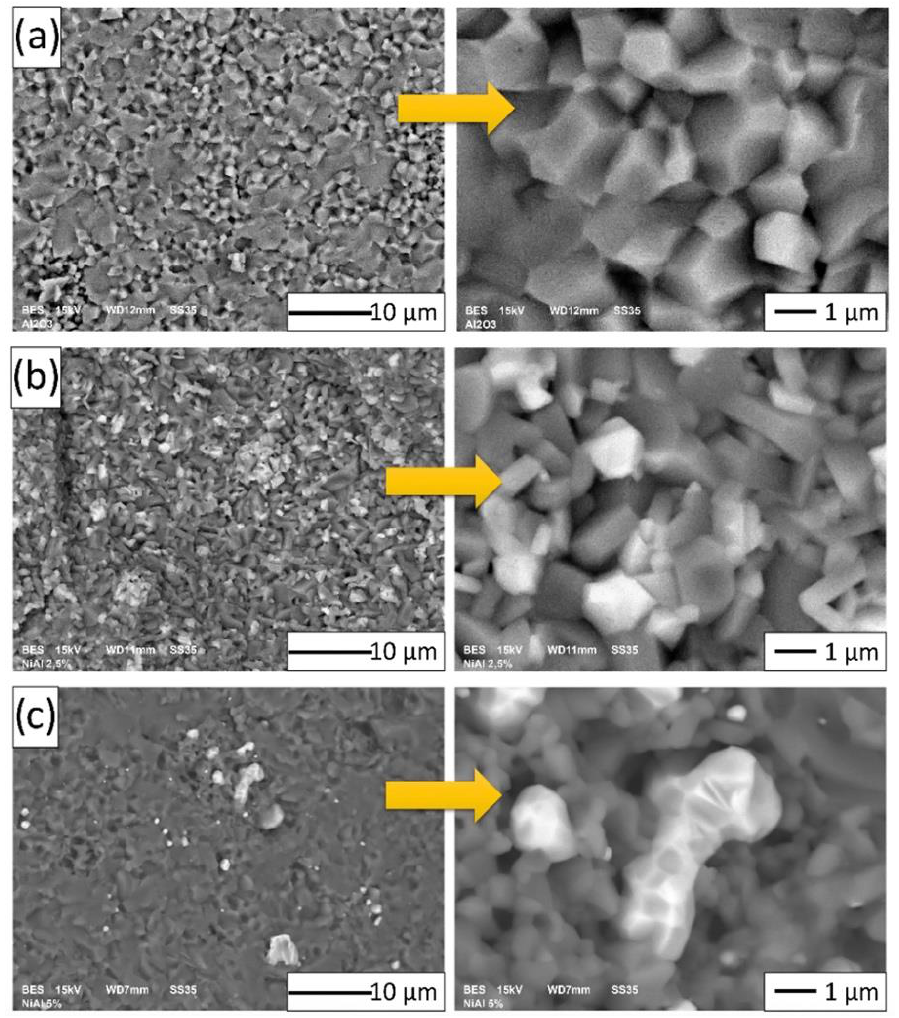
Figure 13. Scanning electron micrograph of the fractures in the fabricated samples: ( a ) Series I—100 vol.% of Al 2 O 3 ; ( b ) Series II—Al 2 O 3 + 2.5 vol.% of NiAl + 30 wt.% A 2 O 3 ; ( c ) Series III—Al 2 O 3 + 5 vol.% of NiAl + 30 wt.% A 2 O 3 .